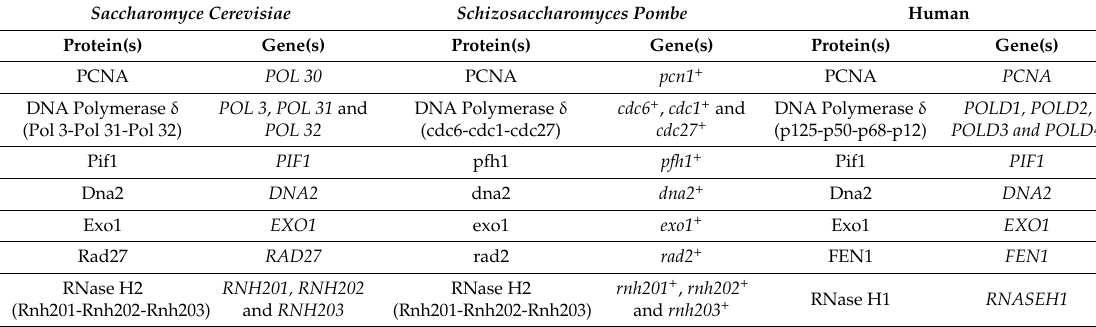
Table 1. Protein factors, complexes and genes involved in OF